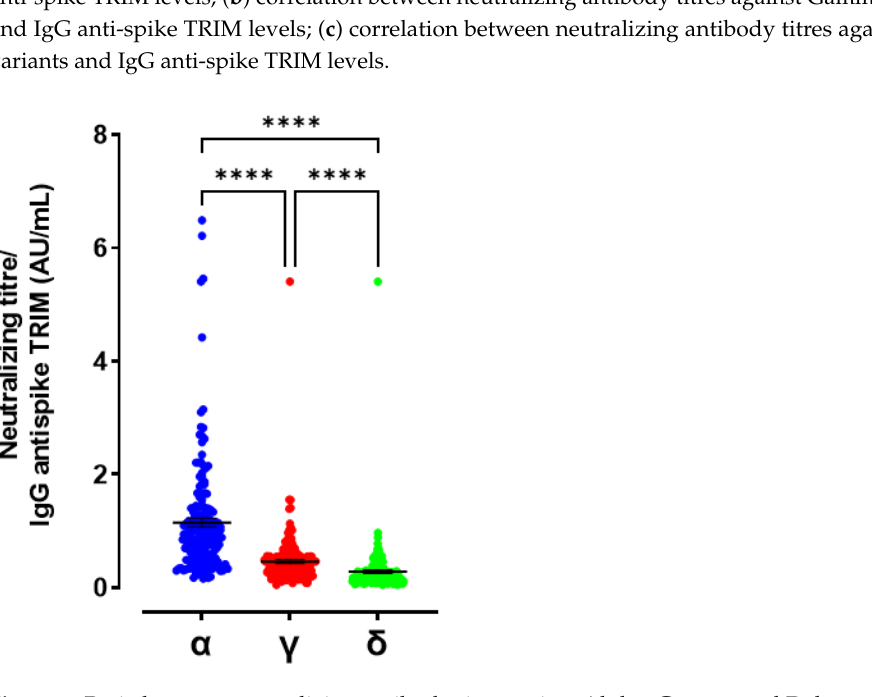
Figure 5. Ratio between neutralizing antibody titre against Alpha, Gamma and Delta variants and IgG anti-spike TRIM levels **** p < 0.0001 .